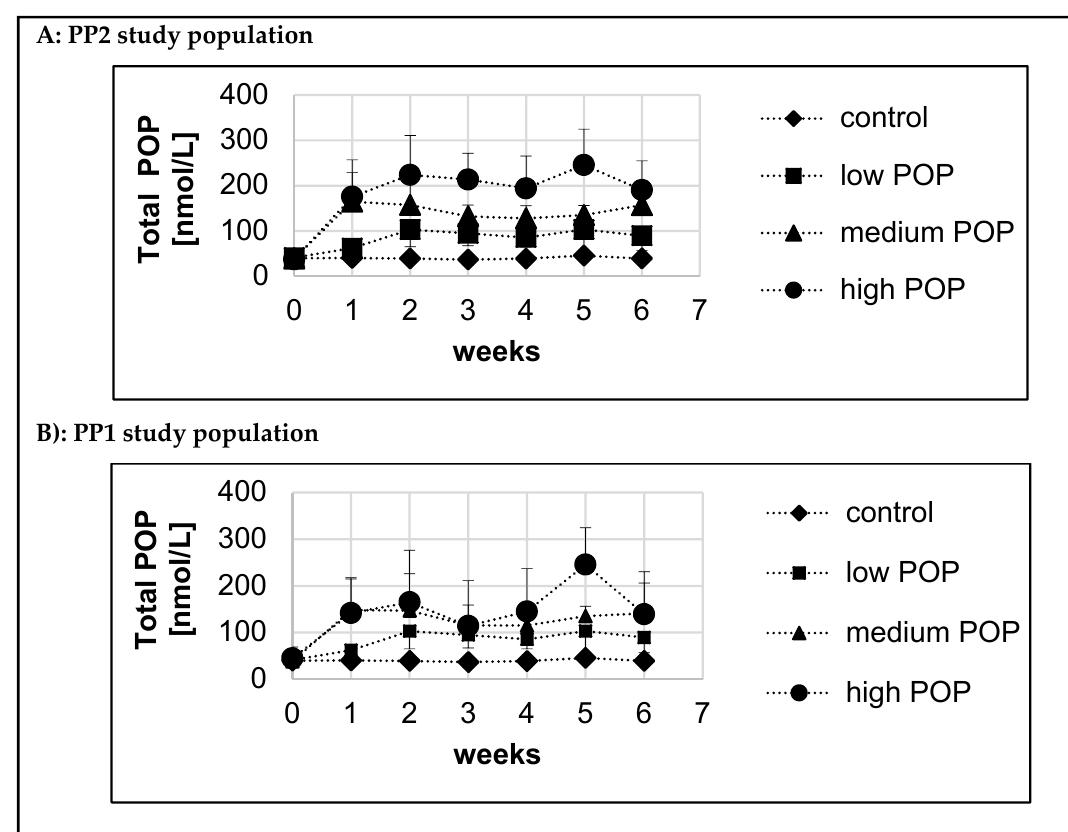
Figure 3. Serum total POP concentrations over time during the six-week dietary intake of increasing doses of POP. Data are presented as mean ± SD. Total POP refer to the sum of all individual POP measured including 7-keto and 7 α - and 7 β -OH derivates of PS. Panel A: PP2 study population( A ). The number of study participants in the di ff erent groups and weeks are: Control: weeks 0, 2, 4 and 6 n = 14; weeks 1 and 5 n = 5; week 3 n = 4; Low POP dose: weeks 0, 2, 4 and 6 n = 15; weeks 1, 3 and 5 n = 5; Medium POP dose: weeks 0, 2, 4 and 6 n = 13; weeks 1 and 3 n = 4; week 5 n = 5; High POP dose: weeks 0, 2, 4 and 6 n = 10; week 1 n = 3, week 3 n = 2 and week 5 n = 5. Serum POP concentrations over time were described by a mono-exponential increase based on a pharmacological model as described in detail under statistical analyses. Based on modelling the time to reach a 90% steady state concentration (Css) was 5 d. Panel B: PP1 study population ( B ). The number of study participants in the di ff erent groups and weeks are: Control: weeks 0, 2, 4 and 6 n = 14; weeks 1 and 5 n = 5; week 3 n = 4; low POP dose: weeks 0, 2, 4 and 6 n = 15; weeks 1, 3 and 5 n = 5; Medium POP dose: weeks 0, 2, 4 and 6 n = 15; weeks 1, 3 and 5 n = 5; High POP dose: weeks 0, 2, 4 and 6 n = 15; weeks 1, 3 and 5 n = 5. Serum